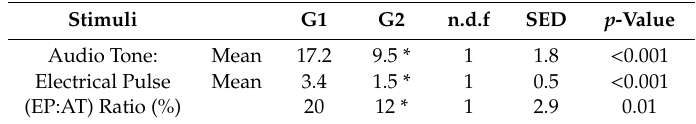
Table 3. Mean number of stimuli delivered per animal per day across the 3 days of each allocation G1 and G2. Number of degrees of freedom (n.d.f.) and standard error of the di ff erence (SED) are presented. * indicates significant di ff erence between means of the same stimuli type.